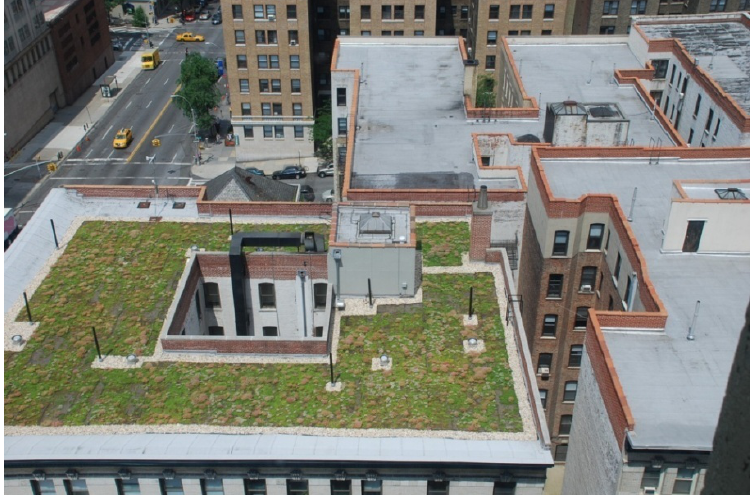
Figure 1. (b) Columbia University, New York green roof research station. This green roof is a thinner ~5 cm deep system planted with mix of sedum species of plants. The roof is one-year old and is ~350 m 2 . Weather station and in situ green roof monitoring equipment are partially visible in the background (photo: S.